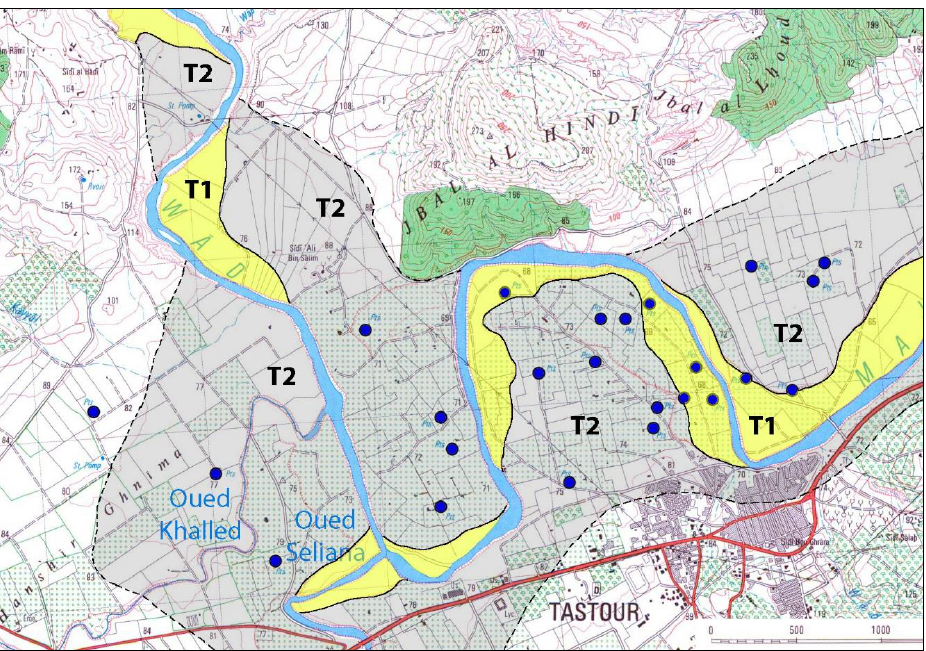
Figure 10. Spatial distribution of waterwheels in the meanders and river terraces of the Medjerda (T1, T2) around Testour. Source: author. (T1, T2) around Testour. Source: